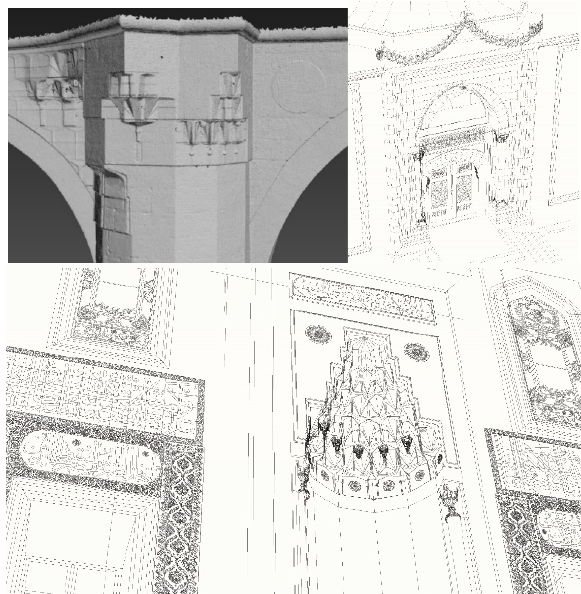
Figure 4. Mesh used for solid modelling in 3ds Max (top left) and 3D CAD drawing of the front door (top right) and section of the interior area (bottom) of Edirne Selimiye mosque For later texture mapping of the solid 3D model of the mosque (Fig. 5) photographs were taken using the Nikon D90 cameras during the field campaign. These images were radiometrically enhanced in Photoshop before texture mapping.